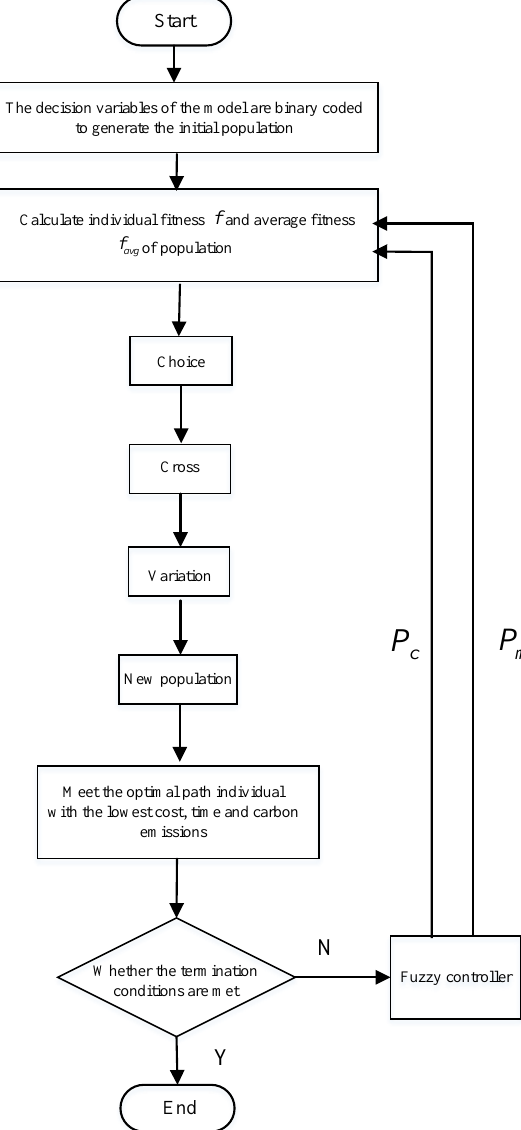
Figure 3. FAGA Basic flow